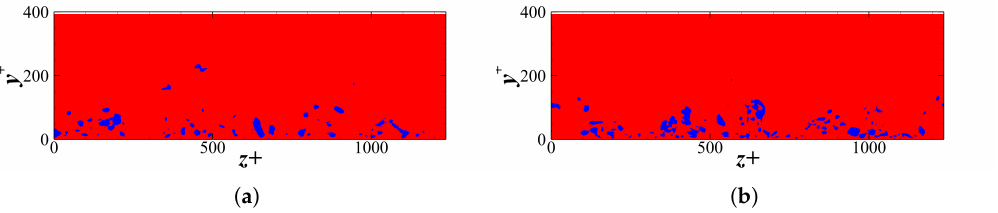
Figure 8. Iso-contours of λ 2 vortices at ( a ) 1 D and ( b ) 3 D downstream of the jets. The iso-contours are drawn for λ 2 = − 3. The instantaneous realization corresponds to t = 2200.